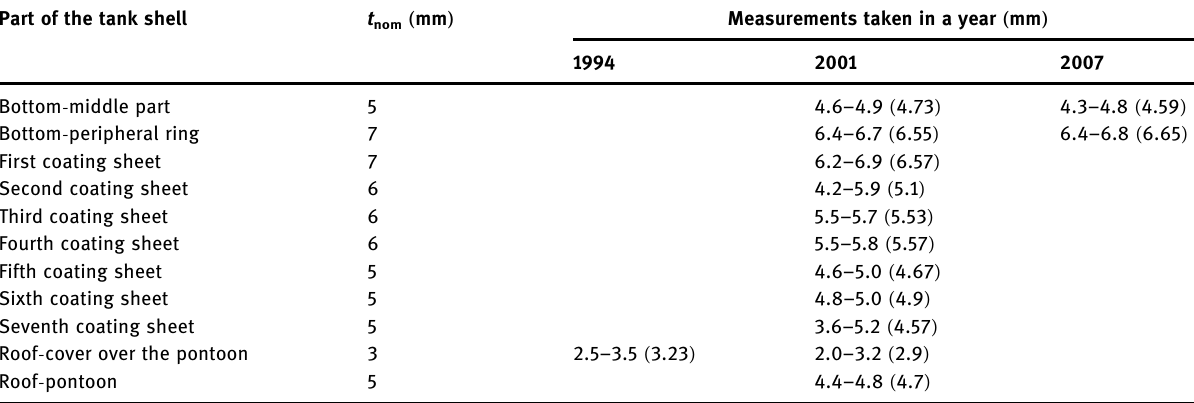
Table 3: Sheet thicknesses measured at di ff erent times in di ff erent locations of the tank number 3 steel shell Part of the tank shell